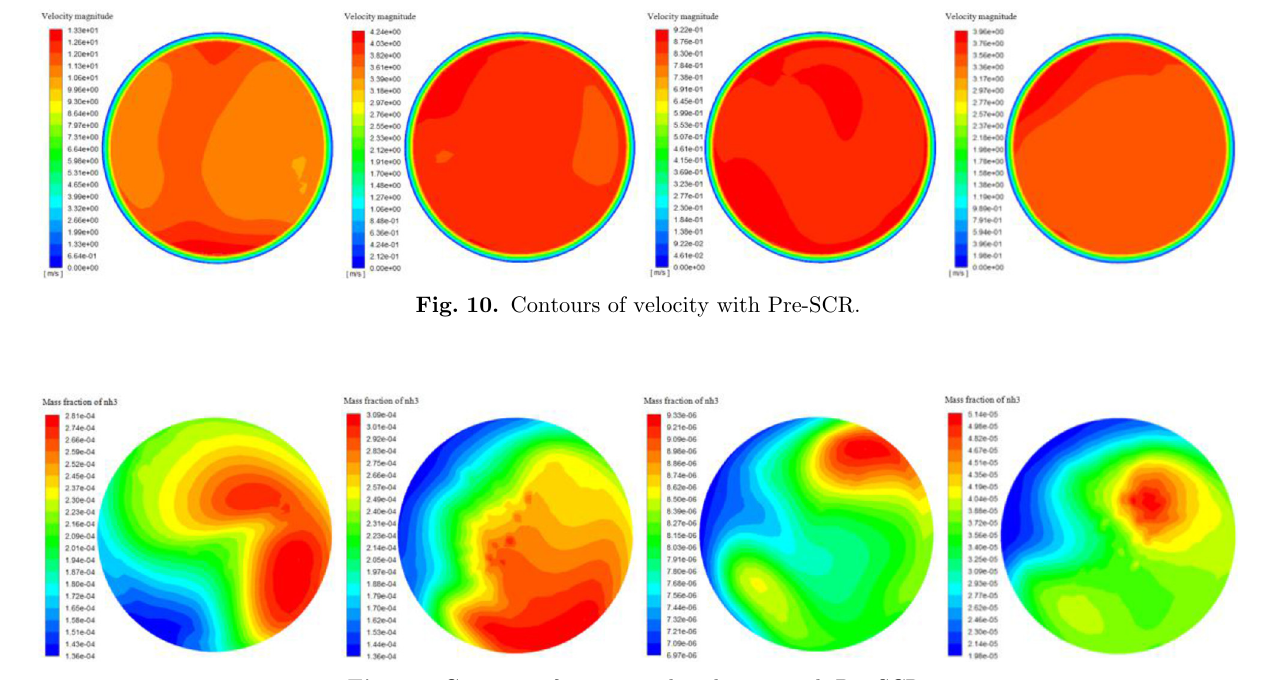
Fig. 11. Contours of ammonia distribution with Pre-SCR.